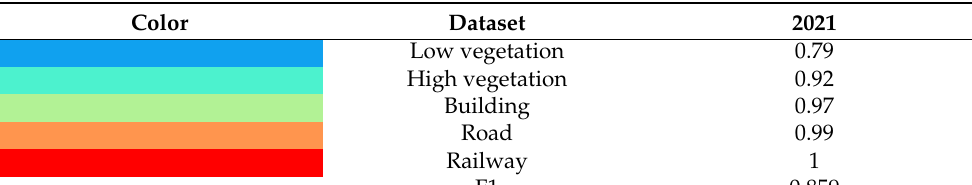
Table 4. The segmentation results of a simulated dataset from 2021.